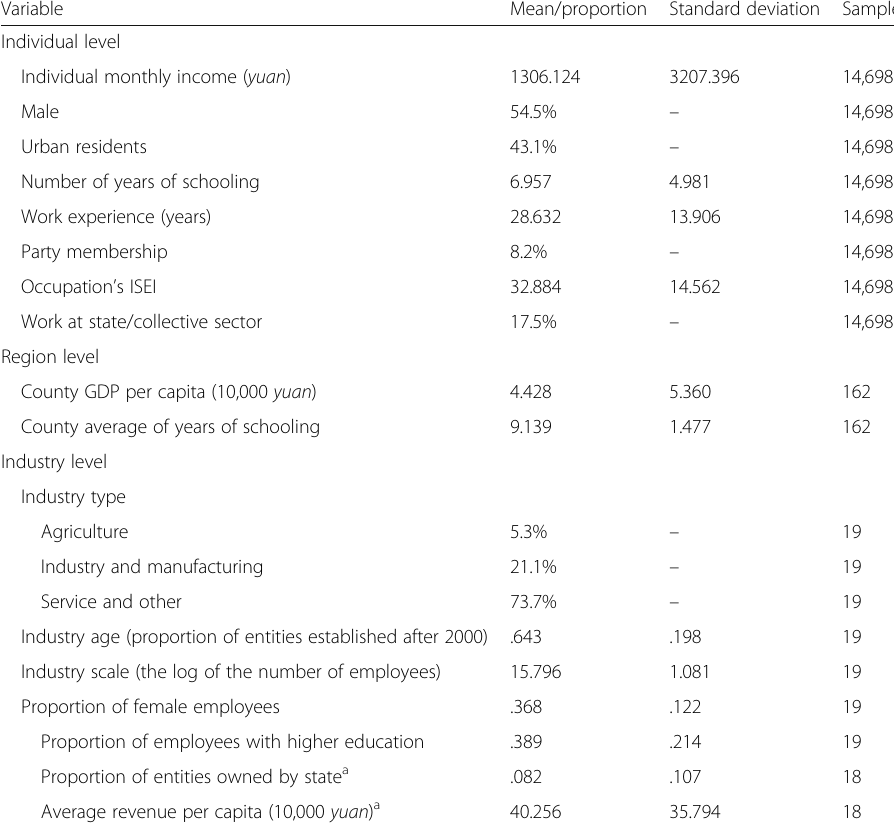
Table 1 Descriptive statistics for key individual, region, and industry